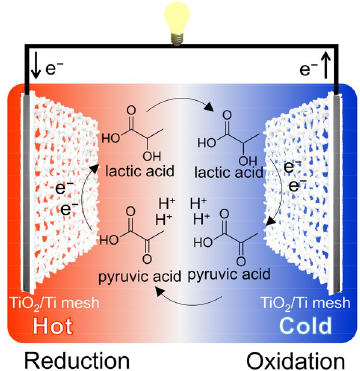
Figure 1. A scheme of thermo-electrochemical (TEC) cell using pyruvic acid and lactic acid as a redox couple and TiO 2 /Ti mesh electrodes. Oxidation (or reduction) reaction proceeds at the cold (or hot) side.